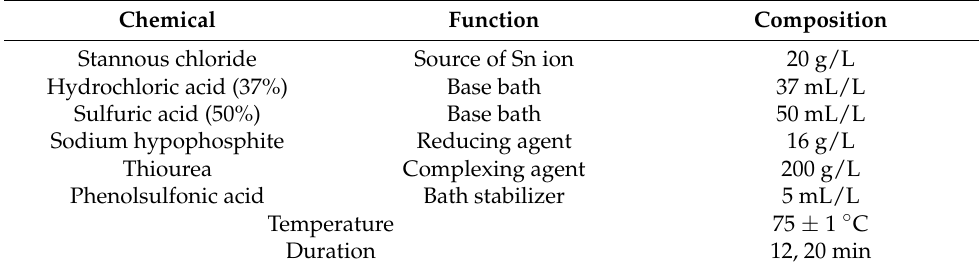
Table 1. Chemical composition for tin plating